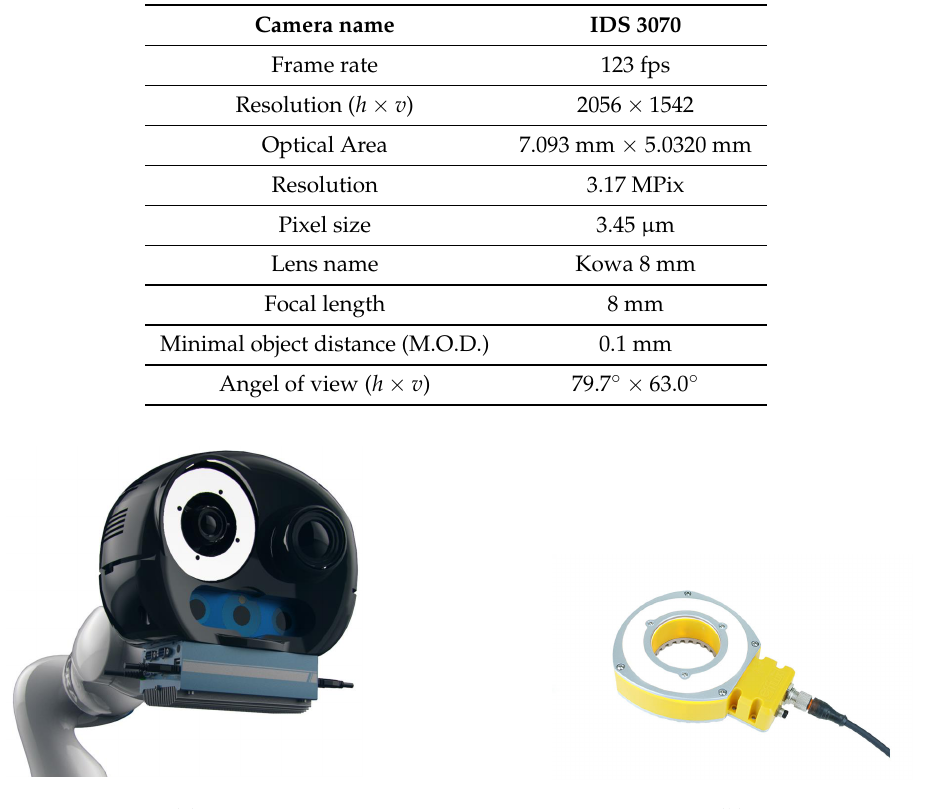
Table 2. Tracking camera specifications.